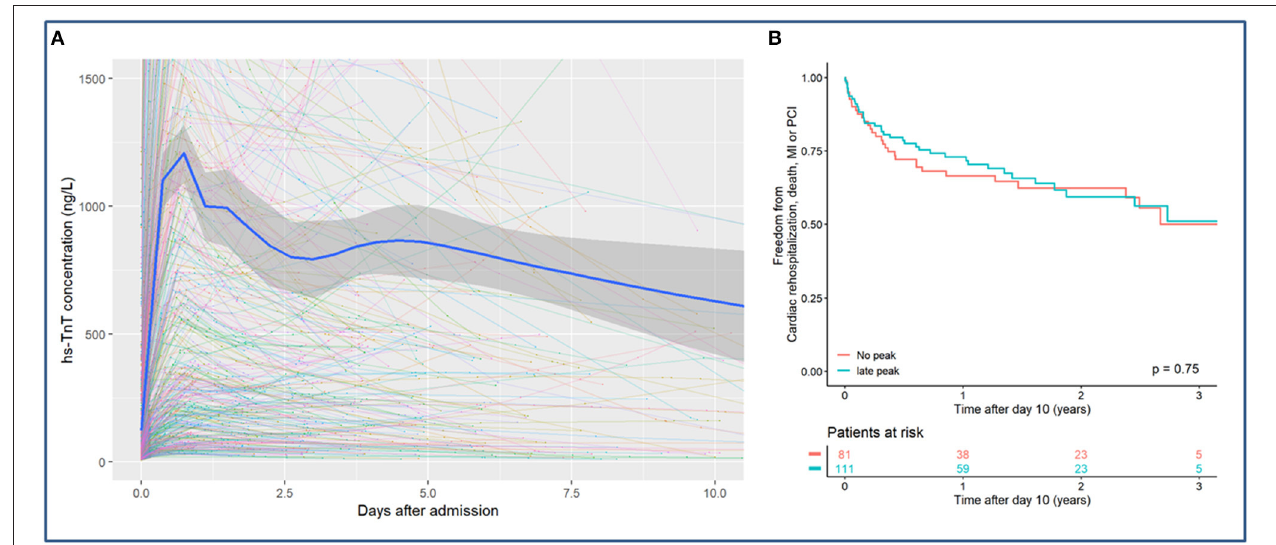
FIGURE 1 | (A) Kinetics of hs-cTnT during the first 10 days after myocardial infarction presented using mixed-model statistics. A second hs-cTnT peak can be detected after 4.48 days after the index event. (B) Kaplan-Meier curve for the combined endpoint of all-cause mortality, rehospitalization, MI or PCI for patients with and without a second hs-cTnT